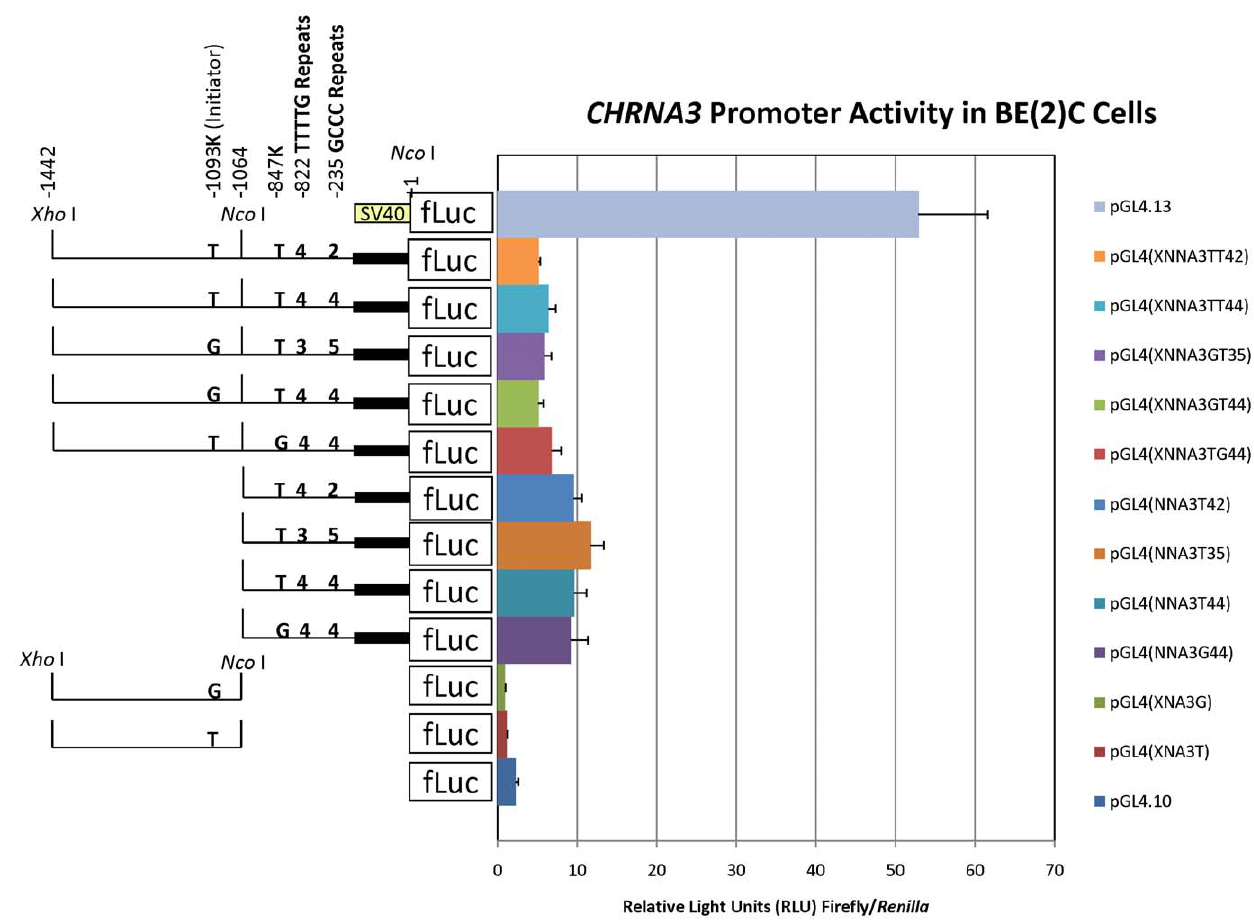
Figure 4. Relative CHRNA3 promoter activity in BE(2)-C cells. Shown are the averages 6 standard deviations of at least three independent experiments each done in triplicate. The SV40 promoter of the positive control vector pGL4.13[luc2/SV40] is indicated by a yellow box. The ‘‘promoterless’’ negative (background) control vector pGL4.10[luc2] is shown without a promoter region in front of the firefly luciferase (‘‘fLuc’’) reporter gene. For experimental CHRNA3 promoter-5 9 UTR constructs, thin and thick black lines represent the promoter and 5 9 UTR portion of the construct, respectively. Positions of the Xho I ( 2 1442) and Nco I ( + 1) sites used for subcloning are indicated, as is an internal Nco I site ( 2 1064). The positions and identities of the rs13329271 ( 2 1093 K; ‘‘initiator’’) and rs12911814 ( 2 847 K) polymorphisms, as well as the number of ‘‘TTTTG’’ repeats ( 2 822 to 2 847) and the number of ‘‘GCCC’’ repeats ( 2 235) within each construct are indicated. There were no statistically significant differences between comparisons of analogous ( i.e. five full length, four 5 9 or two 3 9 truncated) promoter haplotype constructs by ANOVA with Tukey’s HSD post- hoc analysis.